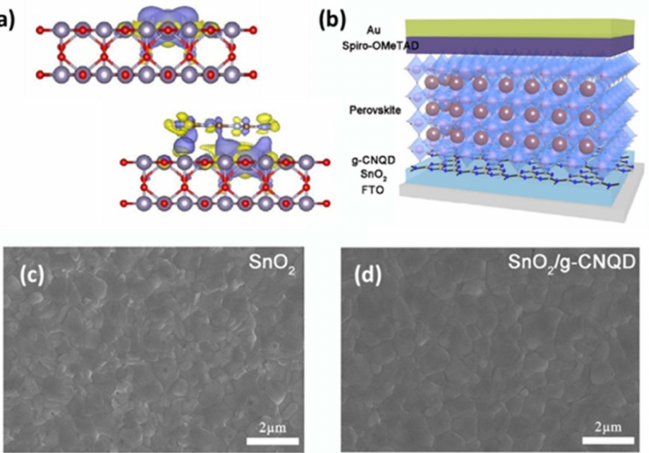
Figure 9. ( a ) The side view for the charge density difference of SnO 2 (up) and G-SnO 2 (down) with oxygen vacancy, reproduced with permission from [51], Copyright 2020, Elsevier. ( b ) Schematic illustration of the PSCs with g-CNQD modified SnO 2 layers, and top-view SEM images of perovskite films based on ( c ) SnO 2 and ( d ) SnO 2 /g-CNQD ETL. Reproduced with permission from